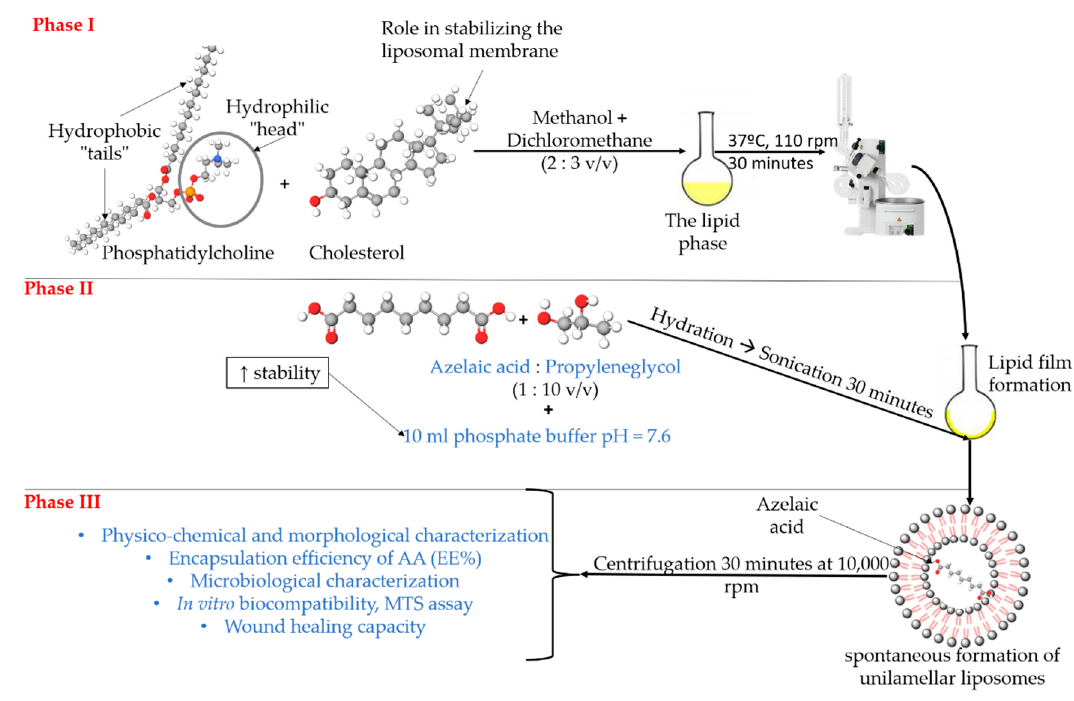
Figure 1. Preparation of phosphatidylcholine liposomes, loaded with azelaic acid. For the homogenization and formation of liposomes with AA of different concentra- tions, the phase II mixture is sonicated for 30 min, then centrifuged for 30 min at 10,000 rpm in order to obtain liposomes of smaller sizes